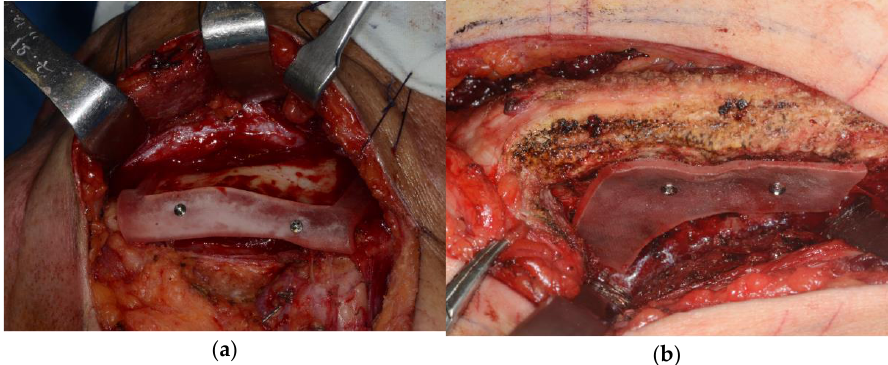
Figure 6. Intraoperative photograph: ( a ) a resection guide was applied on the mandible; ( b ) iliac crest bone and internal oblique muscle flap were harvested using resection guide.